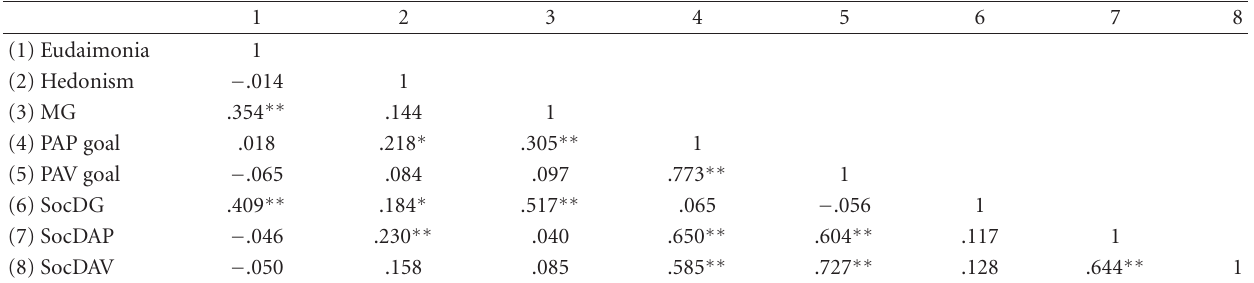
Table 3: Bivariate correlations among all happiness variables, academic achievement goals and social goals.